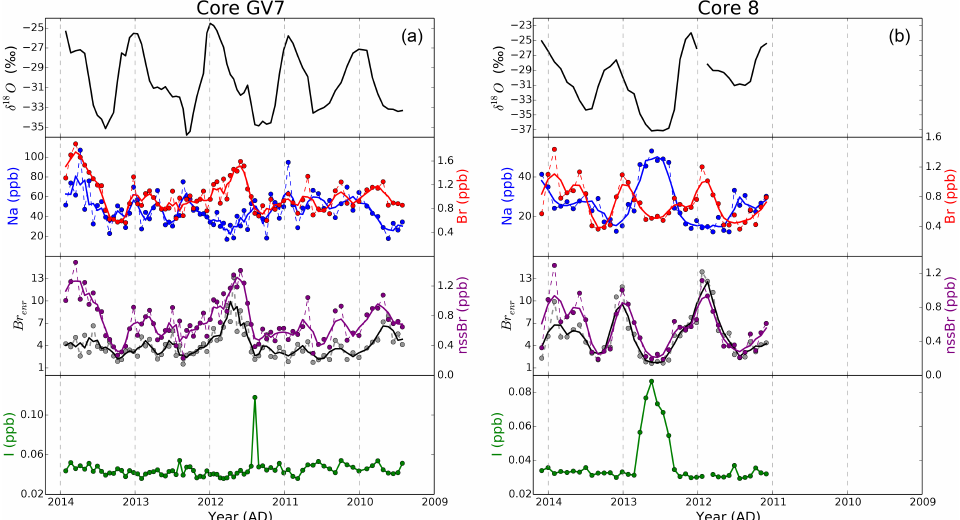
Figure 5. Variability of δ 18 O (upper panel), Na (middle top panel, left axis), Br (middle top panel, right axis), Brenr (middle bottom panel, left axis), nssBr (middle bottom panel, right axis) and I (bottom panel) in cores GV7 (left) and 8 (right). Thick lines represent 3-month running means of the raw data